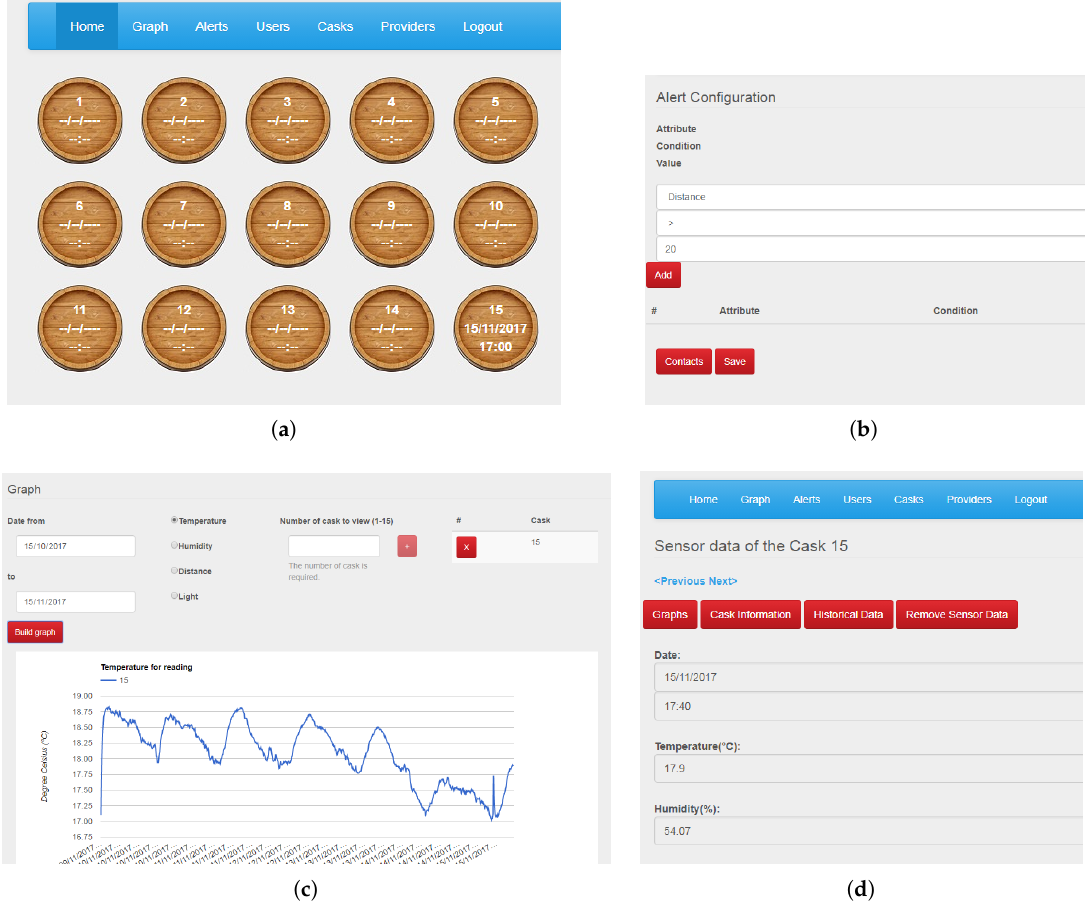
Figure 9. Screenshots of the web UI. ( a ) Overview of the winery casks. ( b ) Alert configuration. ( c ) Graph generation. ( d ) Cask